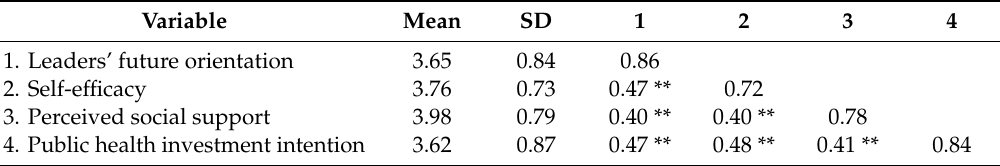
Table 3. Descriptive statistics and Pearson